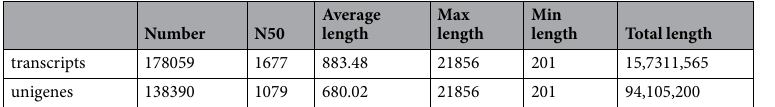
Table 2. The transcripts and unigenes clustered from the de novo assembly.